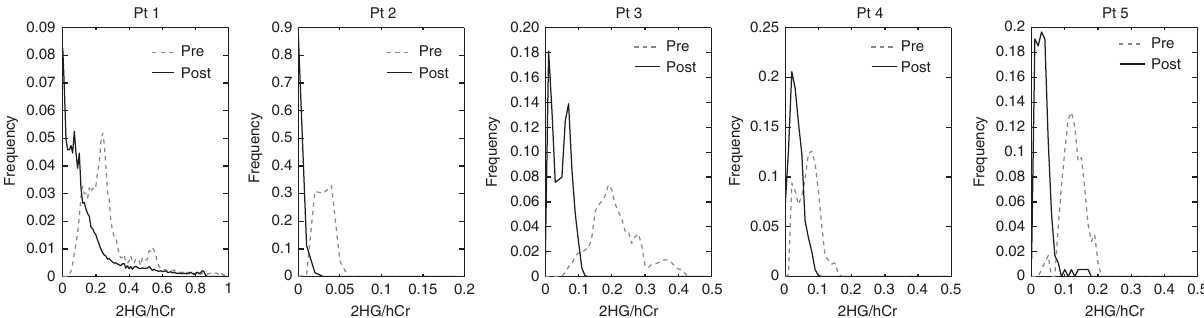
Fig. 2 Histograms of 2HG levels. The distribution of patient 2HG levels within the tumor ROI are shown before (dashed line) and after 1 week (continuous line) of treatment with the mutant IDH1 inhibitor IDH305